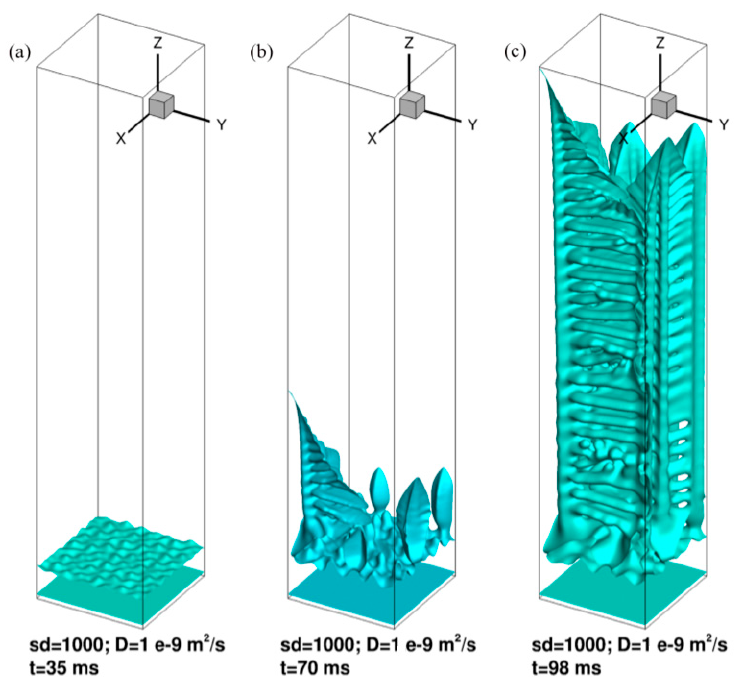
Figure 16. Simulation of non-steady state solidification in 3D with an imposed temperature gradient in the liquid of 2.6 × 10 6 K/m, and an initial interface temperature of 1630 K at ( a ) t= 35 ms, ( b )=70 ms and ( c ) 98 ms.